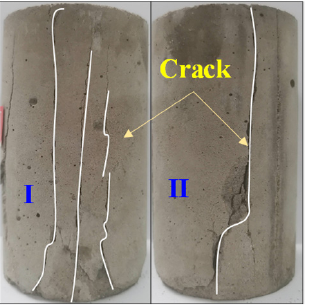
Figure 4. Crack morphology of concrete specimen.